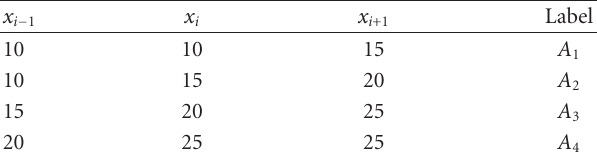
Table 2: Nodes obtained for [8, 37] with n = 4.